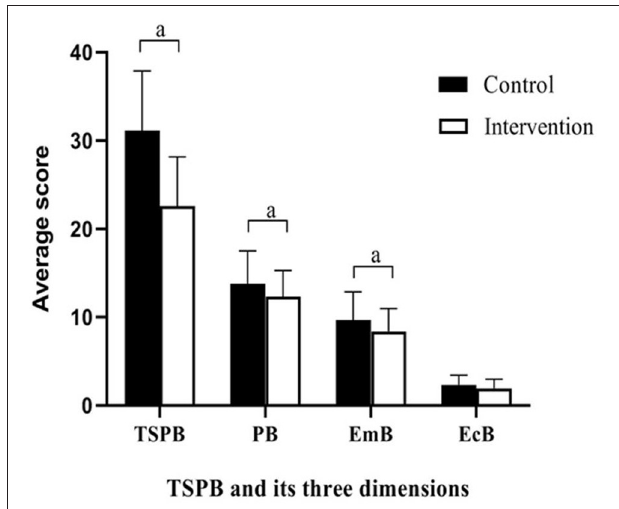
FIGURE 3 | Differences between groups in scores of SPBS at completion of the intervention. Emb, emotional burden; EcB, economic burden; SPB, self-perceived burden; TSPB, total self-perceived burden; a P <